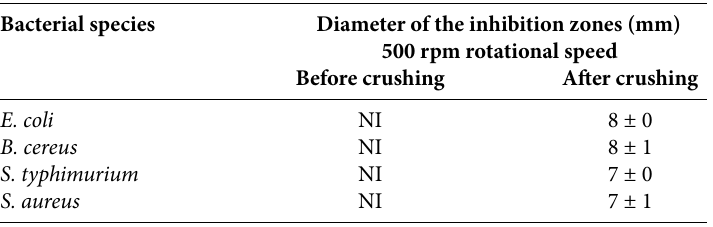
Table 5. Antibacterial activity of the microcapsule incorporated cotton fabric after subjecting to washing conditions Bacterial